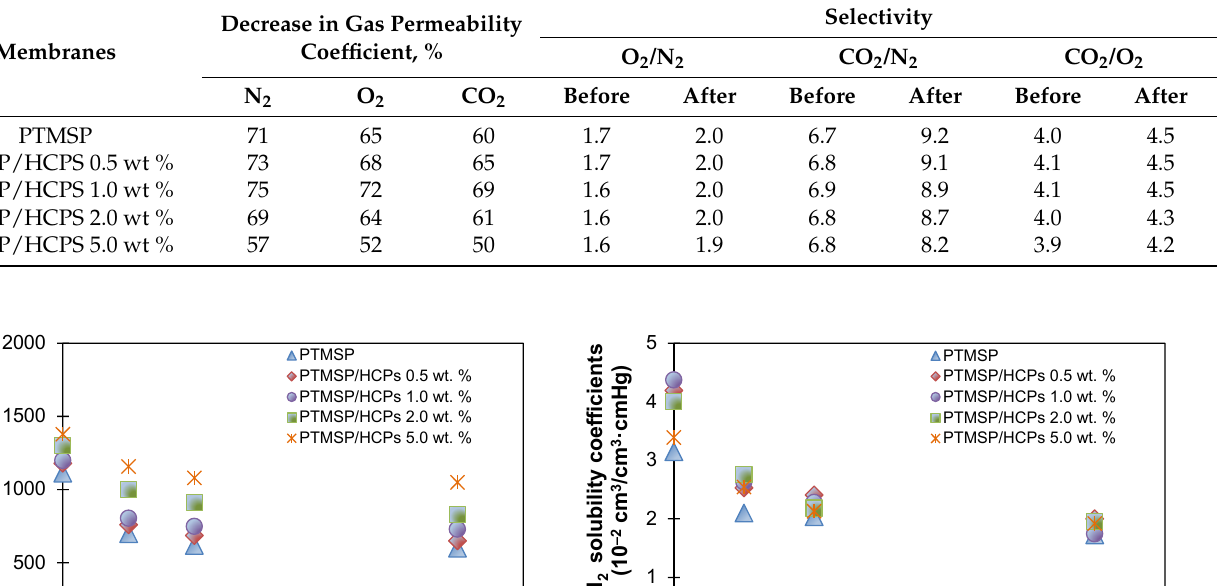
Table 1. Changes in relative gas permeability coefficients and ideal selectivity after annealing at 100 ◦ C for 300 h.